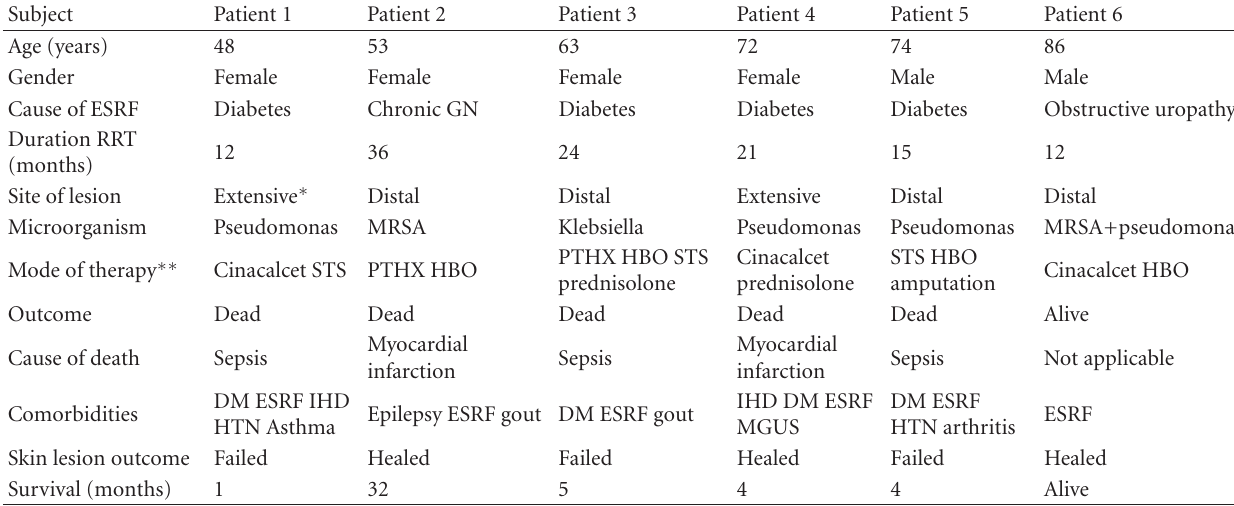
Table 1: Patients’ characteristics and clinical course in subjects with end-stage renal failure presenting with calciphylaxis.